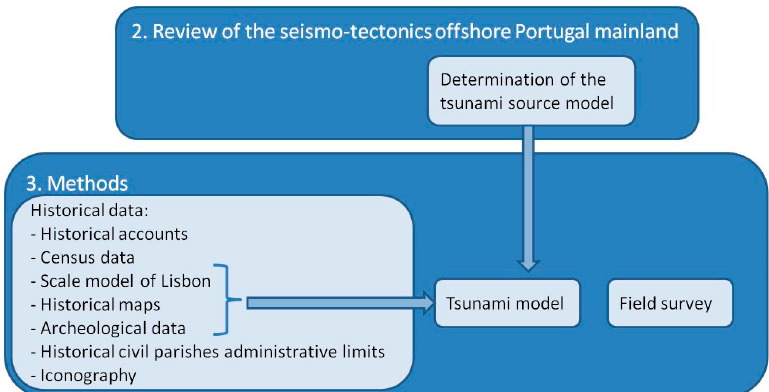
Figure 5. Schematic summary of the methods used in this study.